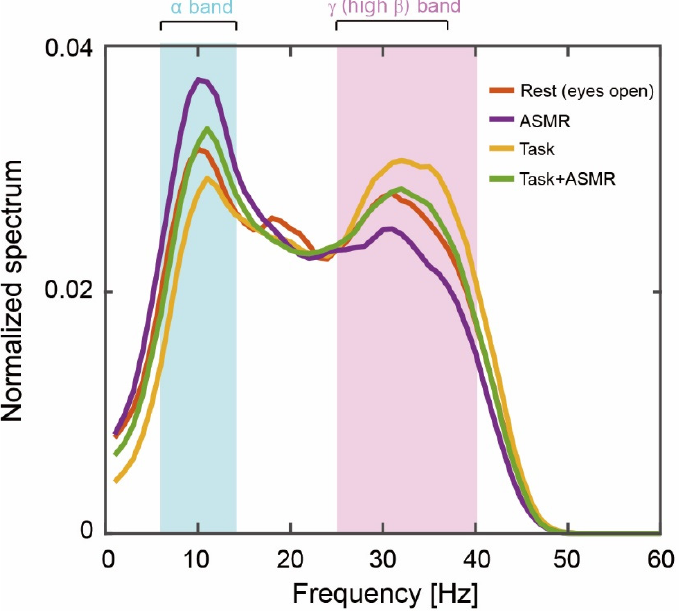
Figure 3. Grand averages of the power spectrum during our experiments. The solid orange, purple, yellow, and green lines indicate the resting condition with open eyes, listening to ASMR sound with open eyes, performing mental tasks without any ASMR, and performing the mental task while lis- tening to ASMR sound, respectively. Pale blue and red areas show alpha-band (6–13 Hz) and gamma (high beta, 25–38 Hz)-band activity.